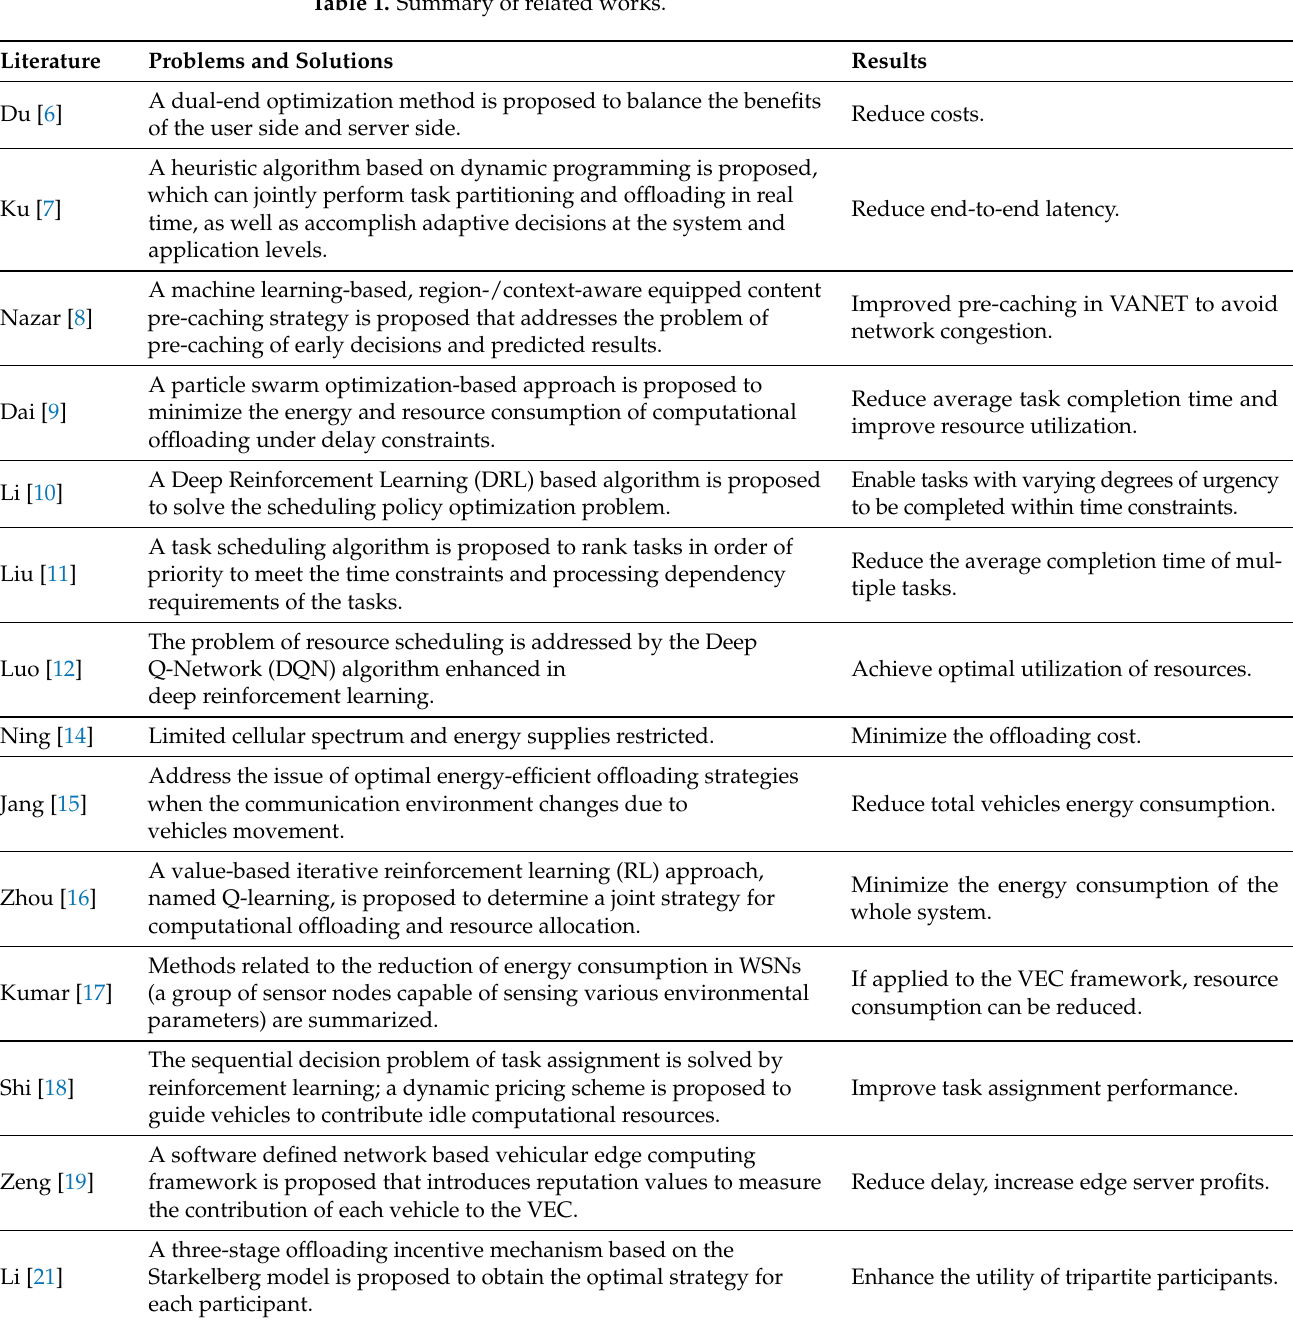
Table 1. Summary of related